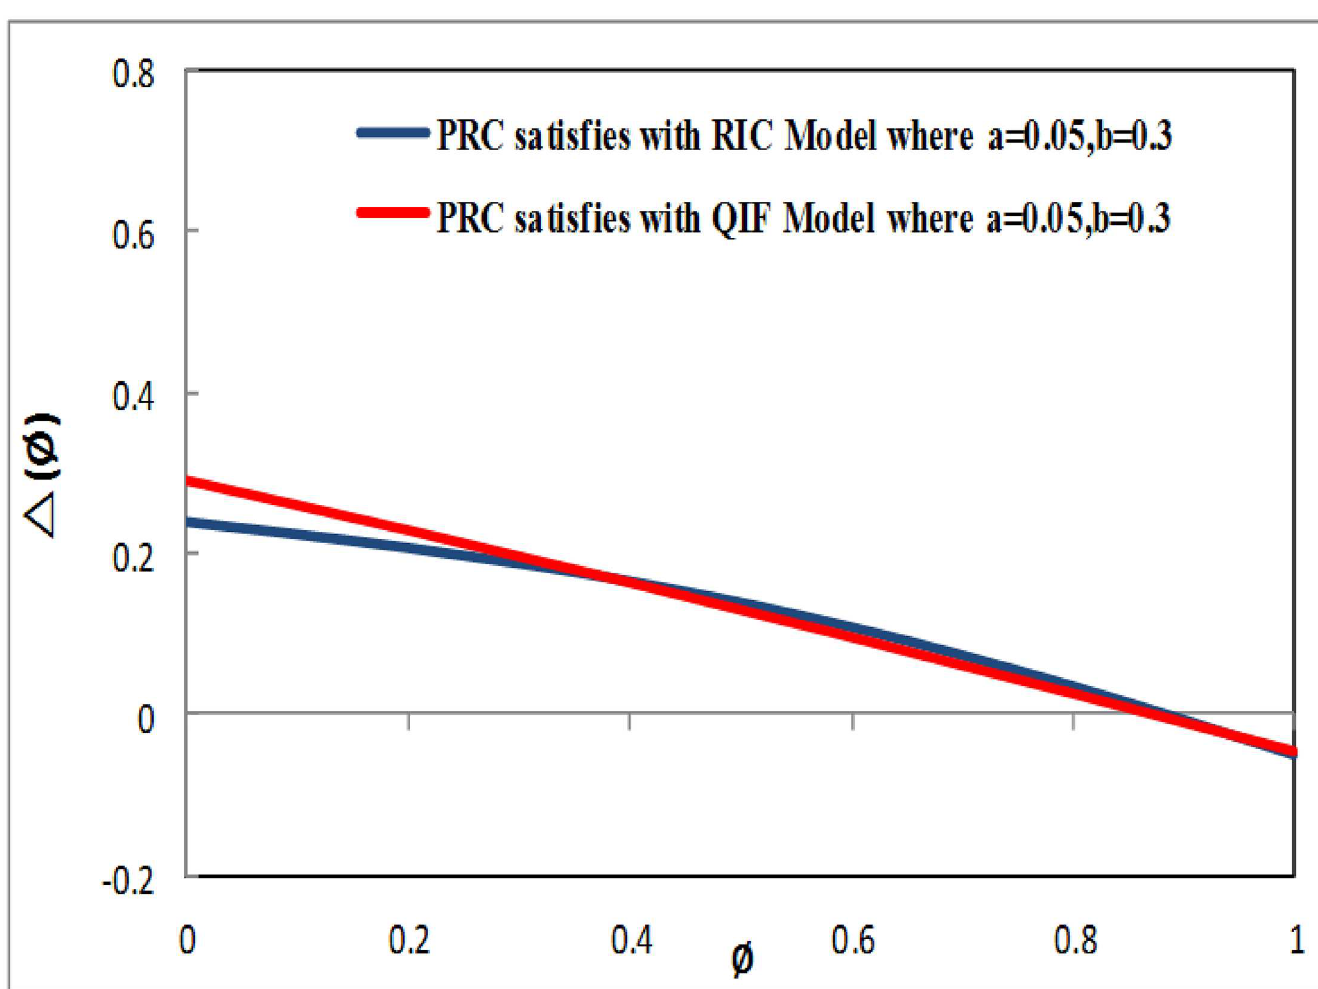
Fig 2. Evaluation of PRC ( Δ s ( ϕ )) with RIC model and QIF